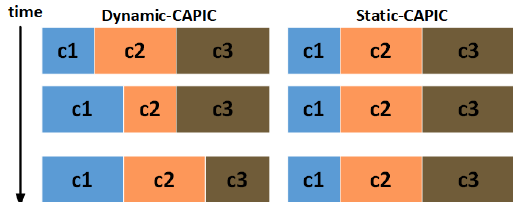
Figure 5. Dynamic-CAPIC vs.